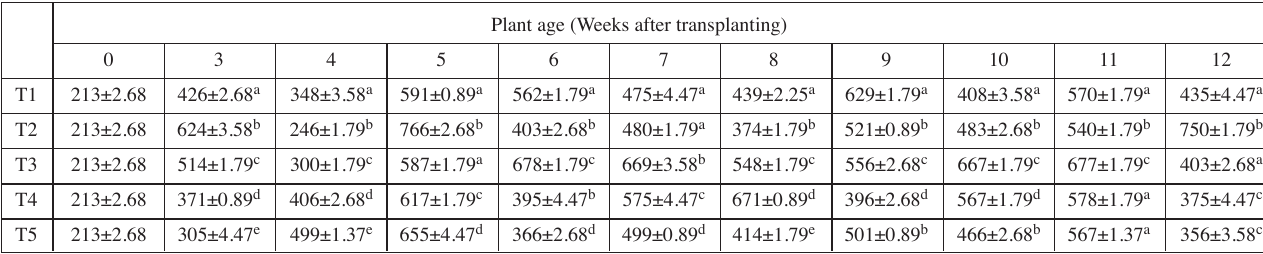
Tab. 3a: Effect of organic and inorganic fertilisers on Fe (mg/kg) of Solanum nigrum L. cultivated in the